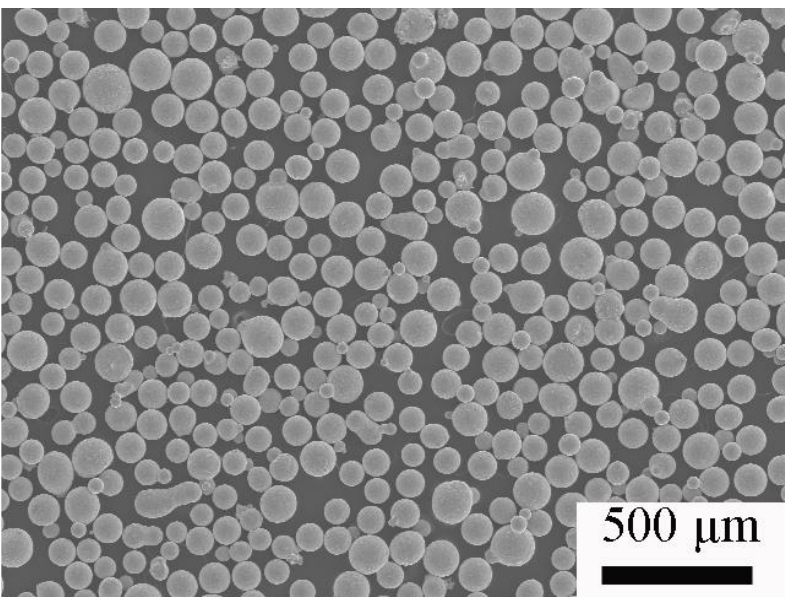
Figure 2. Powder morphology of ultrahigh strength martensitic steel.